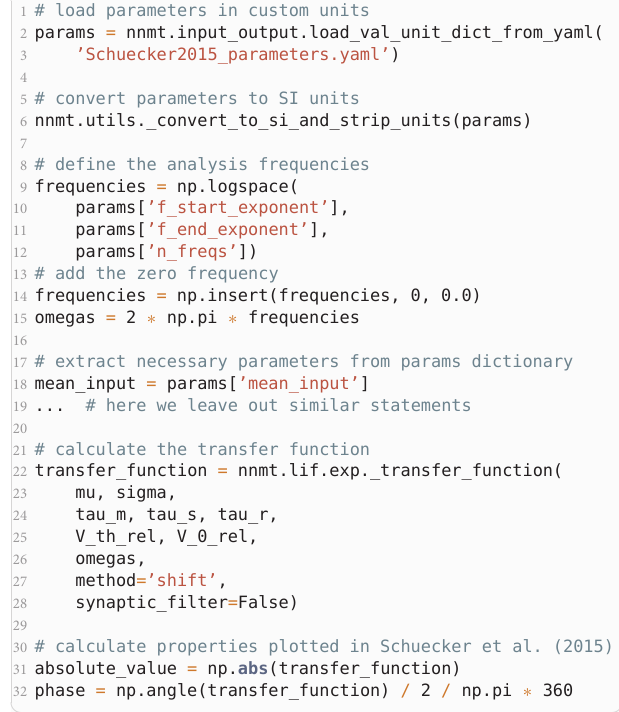
parameters and require the calculation of the firing rates.